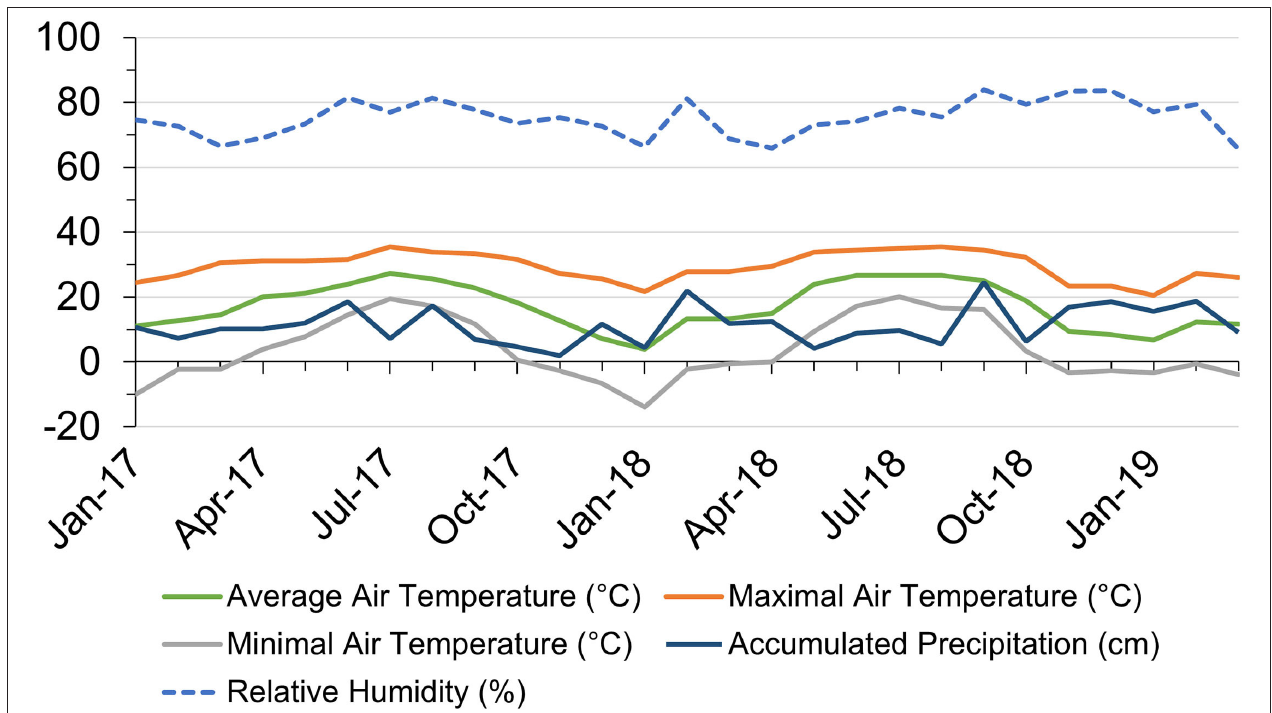
FIGURE 1 | Local monthly air temperature and accumulated precipitation in Starkville, Mississippi (MS), United States within the research duration from January 2017 to March 2019. Data source: